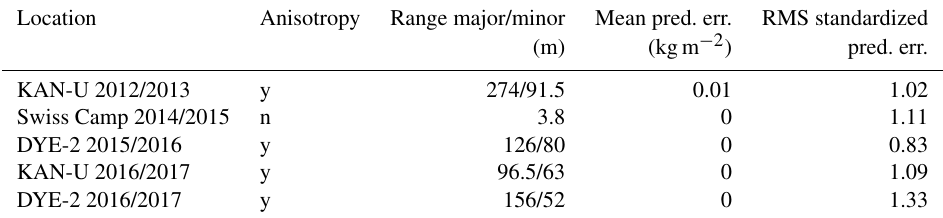
Location Mean pred.